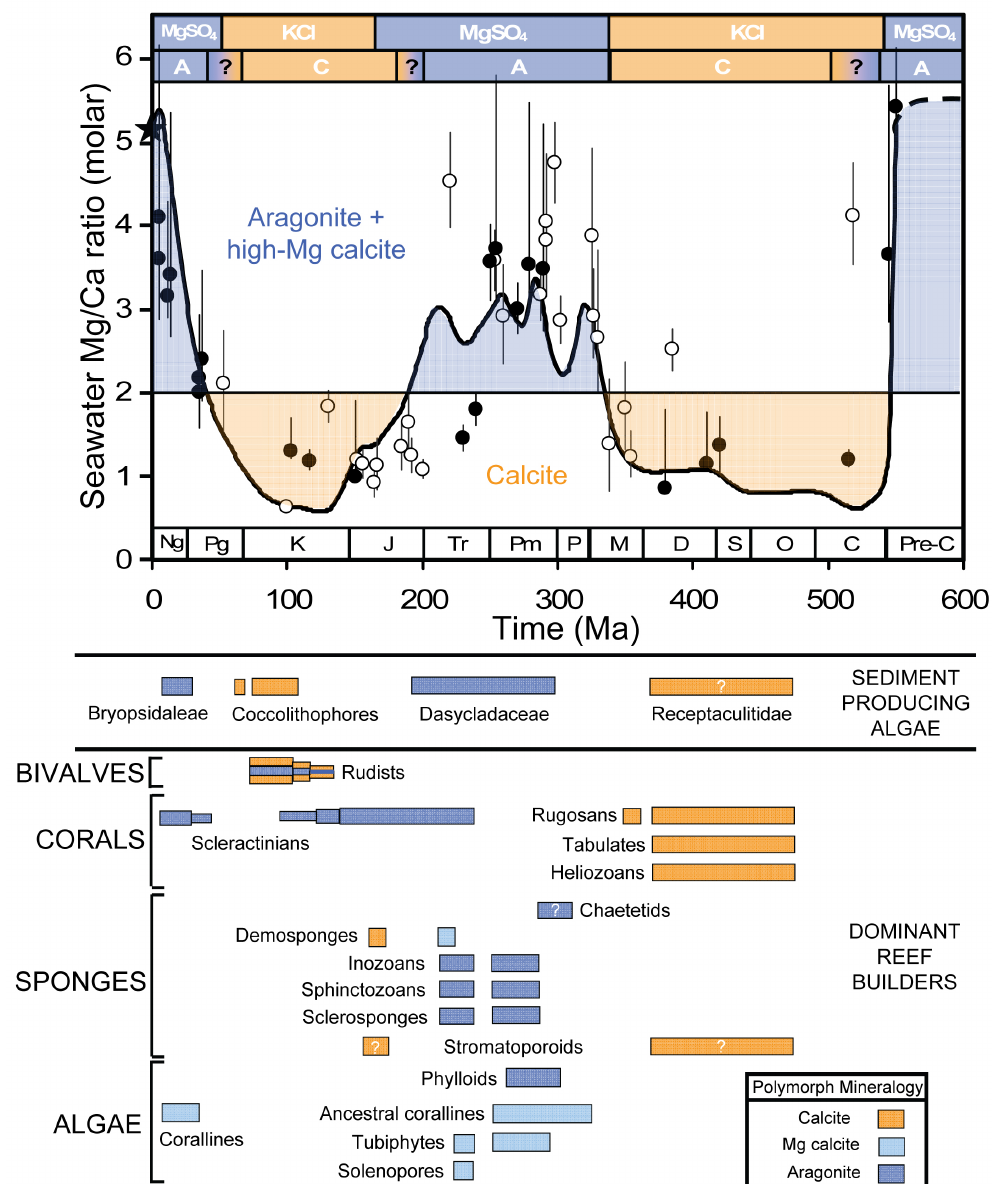
Fig. 1. Synchronized transitions in the mineralogy of dominant reef-building and sediment-producing marine calcifiers, marine evaporites, nonskeletal carbonates, and seawater Mg/Ca ratios throughout Phanerozoic time. Curve is molar Mg/Ca ratio of seawater (Hardie, 1996; Demicco et al., 2005) estimated using a mid-ocean ridge hydrothermal flux/river water mixing model driven by global rates of ocean crust production. Closed circles correspond to seawater Mg/Ca ratios estimated from fluid inclusions in primary marine halite (Lowenstein et al., 2001, 2003, 2005; Brennan, 2002; Horita et al., 2002; Brennan and Lowenstein, 2002; Brennan et al., 2004; Timofeeff et al., 2006). Open circles are seawater Mg/Ca ranges estimated from the Mg content of fossil echinoids [recalculated from Dickson (2002) by Ries (2004) using available paleotemperature data and a nonlinear, empirically-derived Mg-fractionation algorithm]. Star represents modern seawater (Mg/Ca=5.2). Horizontal line divides the calcite (Mg/Ca < 2) and aragonite + high Mg calcite (Mg/Ca > 2) nucleation fields in seawater at 25 ◦ C. Intervals of primarily aragonitic (“A”) and calcitic (“C”) abiotic precipitates (ooids, marine cements, seafloor precipitates; Sandberg, 1983; Lasemi and Sandberg, 2000) and KCl and MgSO 4 marine evaporites (Hardie, 1996) are plotted along top of figure. These data suggest that secular variation in seawater Mg/Ca ratios throughout Phanerozoic time supported three intervals of predominantly aragonite + high Mg calcite precipitation (seawater Mg/Ca > 2) alternating with two intervals of predominantly calcite precipitation (seawater Mg/Ca < 2). Adapted from Stanley and Hardie